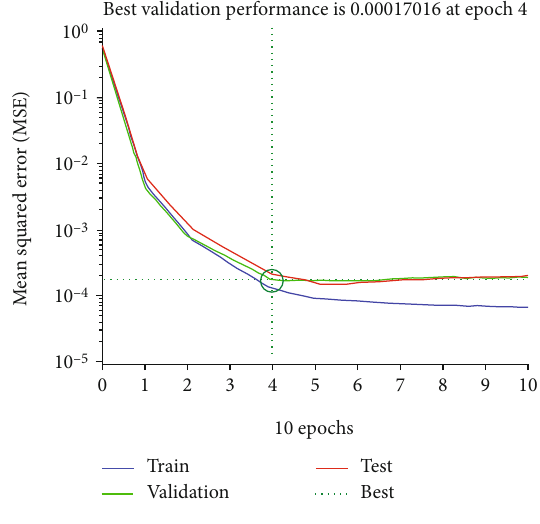
Figure 4: Performance